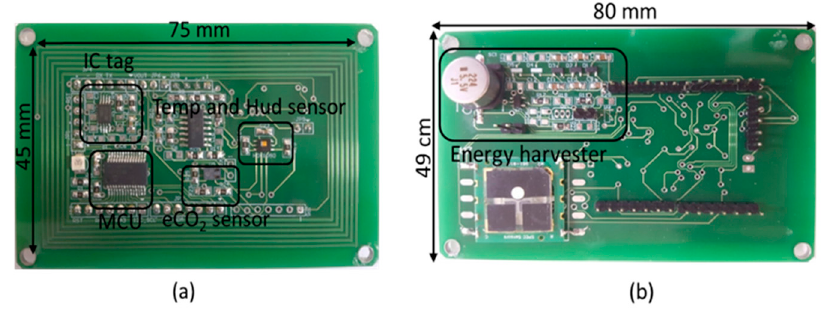
Figure 8. Photograph of wireless passive smart sensor module: ( a ) top layer and ( b ) bottom layer.